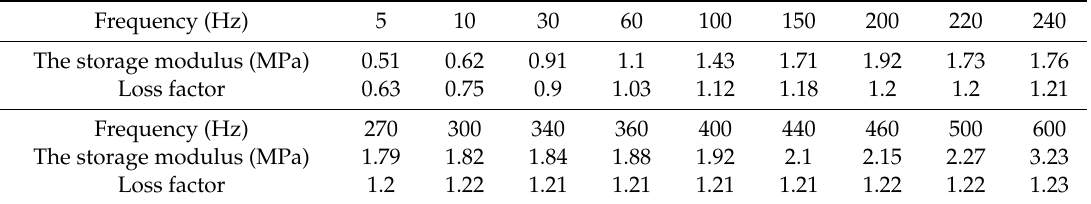
Figure 6. VISCOANALYSEUR VA4000 dynamic viscoelastic spectrometer. Table 1. Measured values of storage modulus and loss factor of the viscoelastic materials at different frequencies at 30 °C.